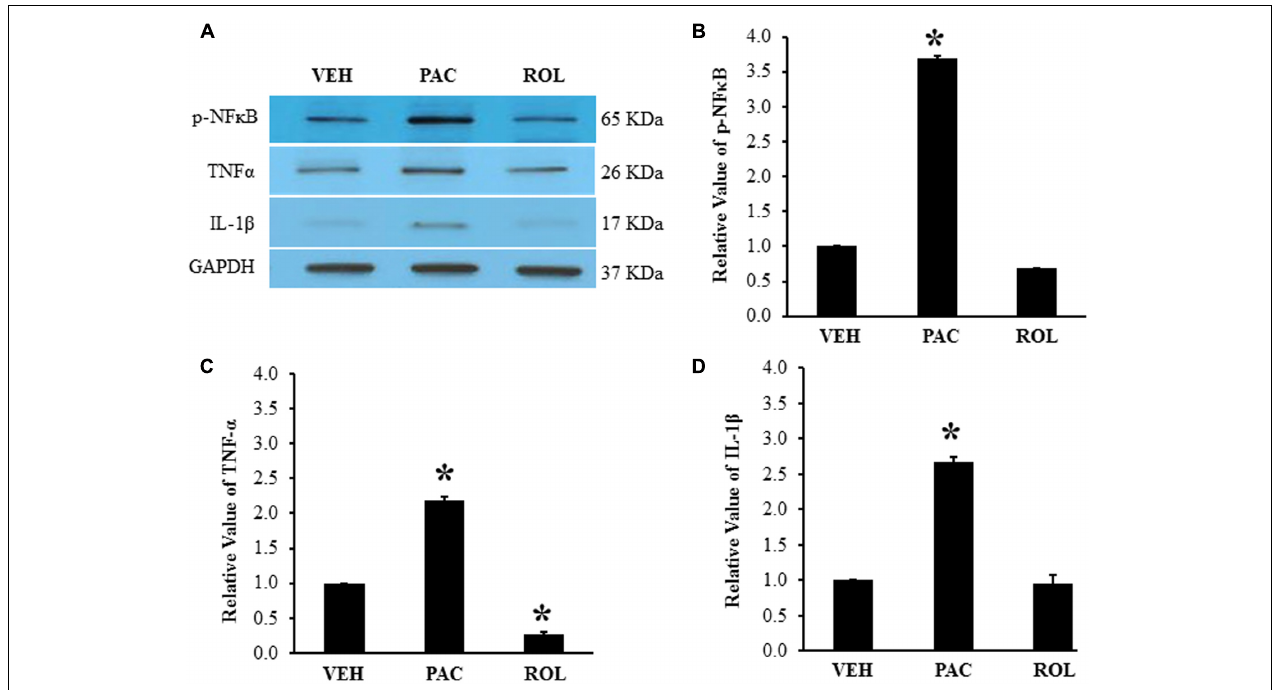
FIGURE 2 | Paclitaxel increased levels of p-NF κ B, TNF- α , and IL-1 β in rat DRGs. (A) Western blot showing the expression of p-NF κ B, TNF- α , and IL-1 β in DRGs after an injection of vehicle (VEH, N = 3) or paclitaxel (PAC, N = 3) on day 20 after the first paclitaxel injection. Rolipram (PAC+ROL, 3 mg/kg, N = 3) was intraperitoneally injected on day 20 after the first injection of paclitaxel, and the L1–L6 DRGs were obtained 1 h after the injection. (B–D) Quantification of p-NF κ B, TNF- α , and IL-1 β in the DRGs. Paclitaxel increased the levels of p-NF κ B, TNF- α , and IL-1 β in rat DRGs, and subsequent treatment with rolipram decreased them. The data are expressed as means ± standard deviations for three rats. The asterisks indicate values that are significantly different ( P < 0.05) from the values for the vehicle group as determined by the Mann–Whitney U